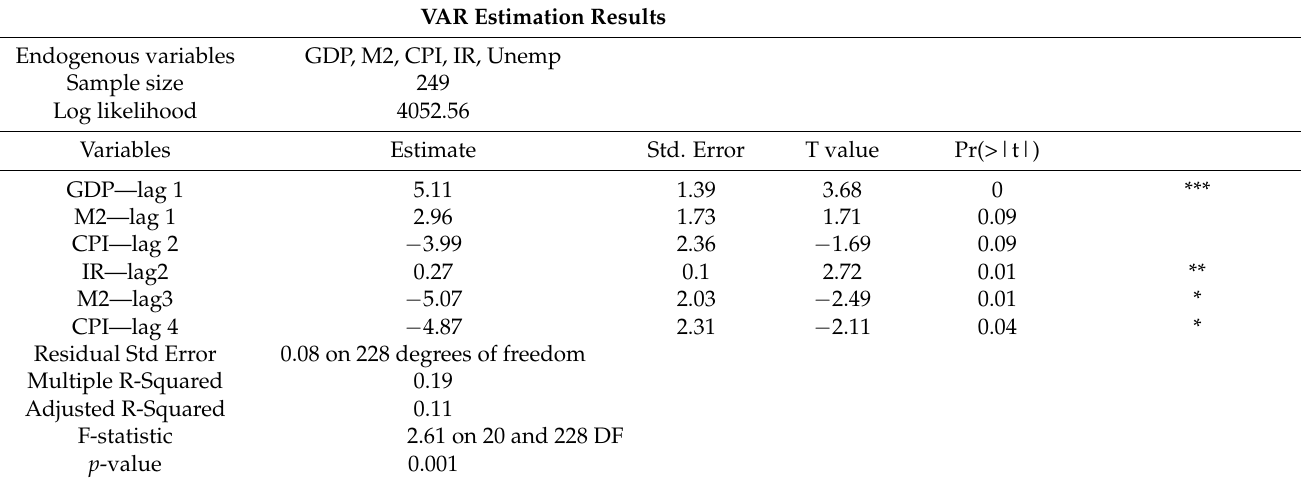
Table 8. VAR estimation for Interest rate (IR). VAR Estimation